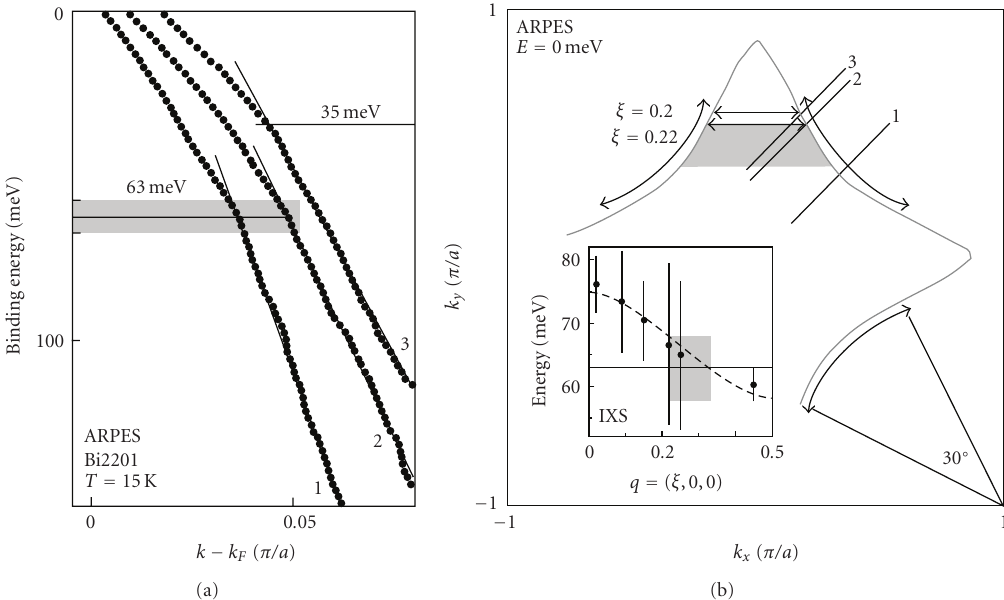
Figure 18: (a) MDC dispersions measured for three di ff erent momentum cuts along the G - Y orientation with cut 1 at the nodal point while cuts 2 and 3 are further toward the BZ boundary, near to the edge of the pseudogap phase Fermi arrows [65]. (b) Fermi surface with the cuts from (a) indicated. The solid line indicates a constant energy contour at the kink energy, 63meV, while the shadow area indicates the region where the nodal kink appears bounded by the indicated nesting wavevectors. The inset shows the IXS dispersion and peak FWHM (seen as error bars) of the BS mode. Note: The apparent Fermi arcs due to the experimental resolution are indicated by the curved arrows. The complete figures can be found in